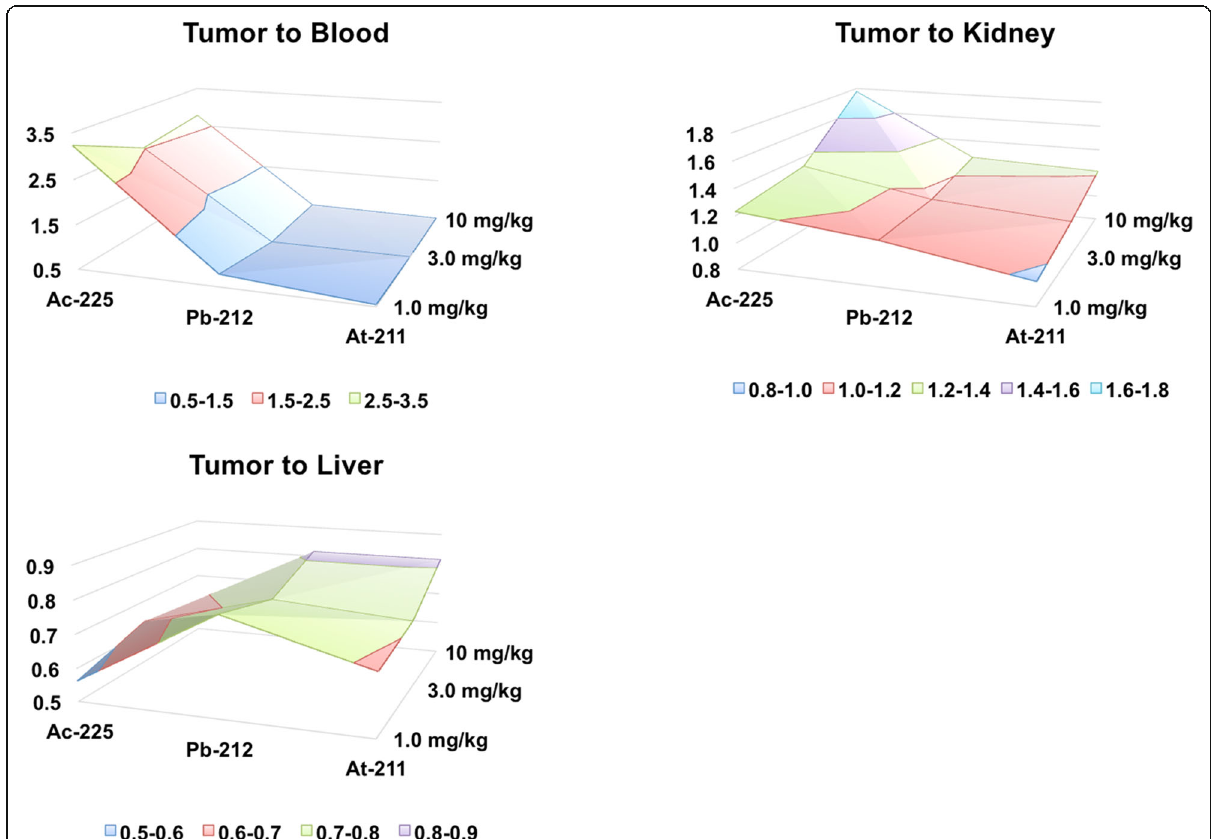
Fig. 12 Time-integrated activity ratios (dimensionless) a tumor to blood (TIA-tumor/TIA-blood), b tumor to kidney (TIA-tumor/TIA-kidney), and c tumor to liver (TIA-tumor/TIA-liver) for 225 Ac-, 212 Pb-, and 211 At-labeled anti-PD-L1-BC for the 1.0, 3.0, and 10 mg/kg protein